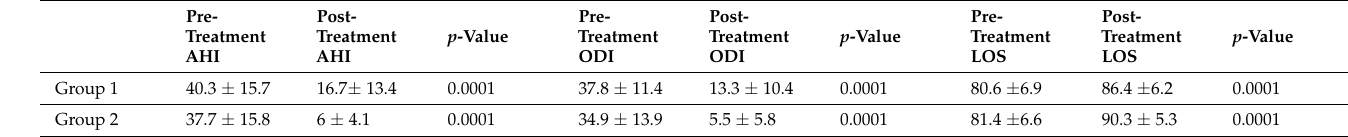
Table 3. Statistical difference between pre- and post-treatment sleep apnea respiratory outcomes.